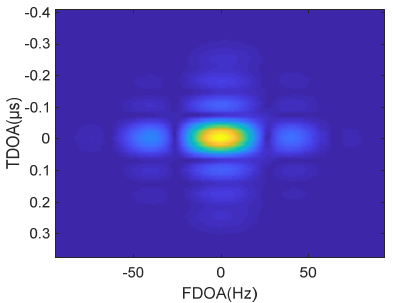
Figure 16. Results after joint processing.